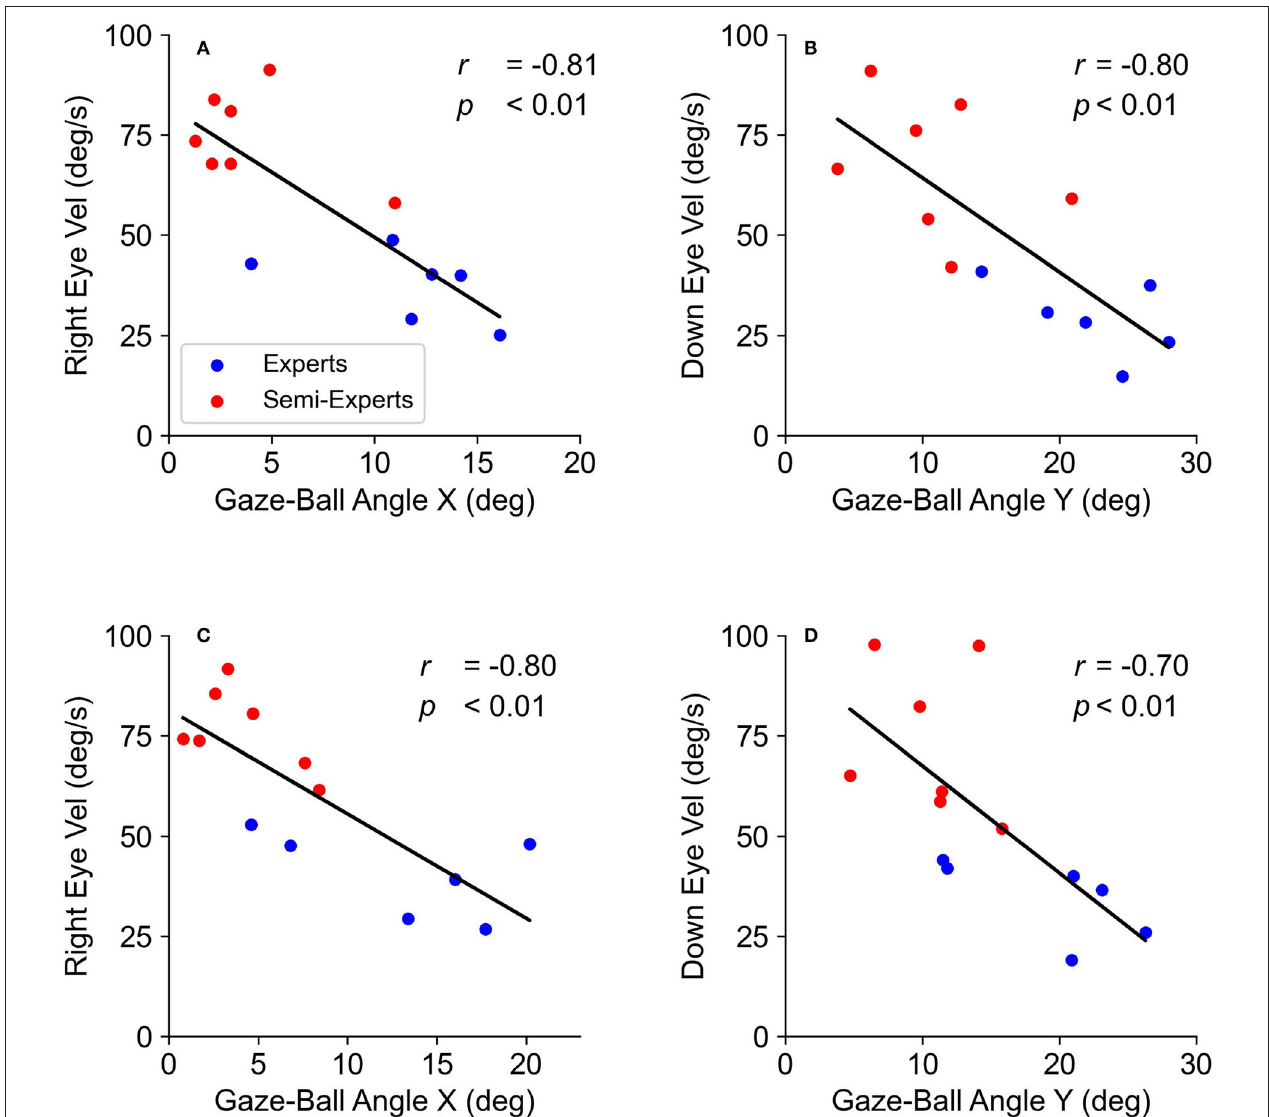
FIGURE 9 | The relationship between the gaze-ball angle and eye velocity in each tempo. The top two panels (A,B) show the data at 130 bpm. The bottom two panels (C,D) show the data at 150 bpm.